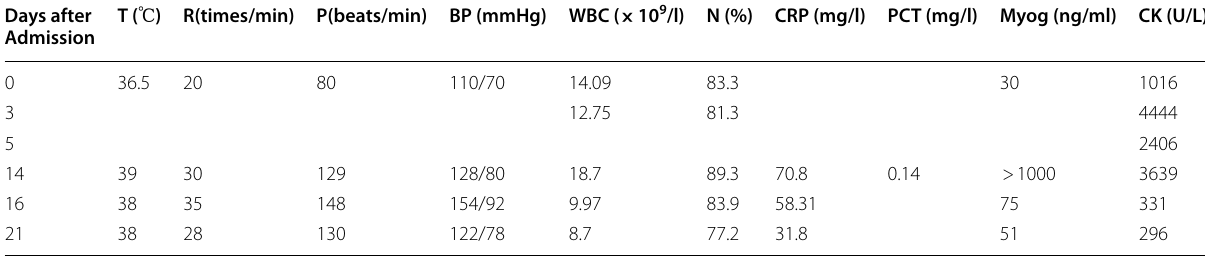
Table 3 Changes in the laboratory tests in different days of Case